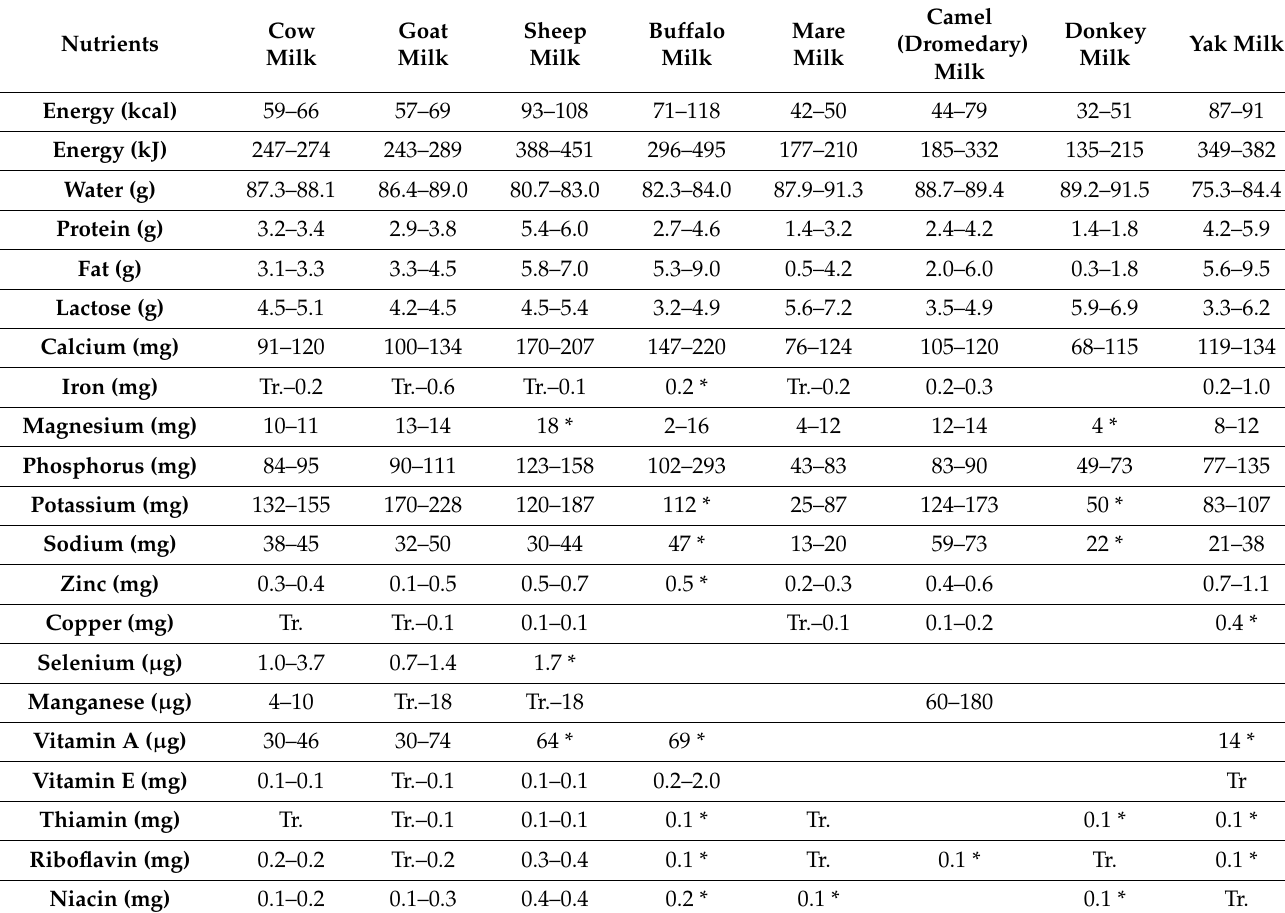
Table 1. The composition of milk from various animals (per 100 g of fresh milk)